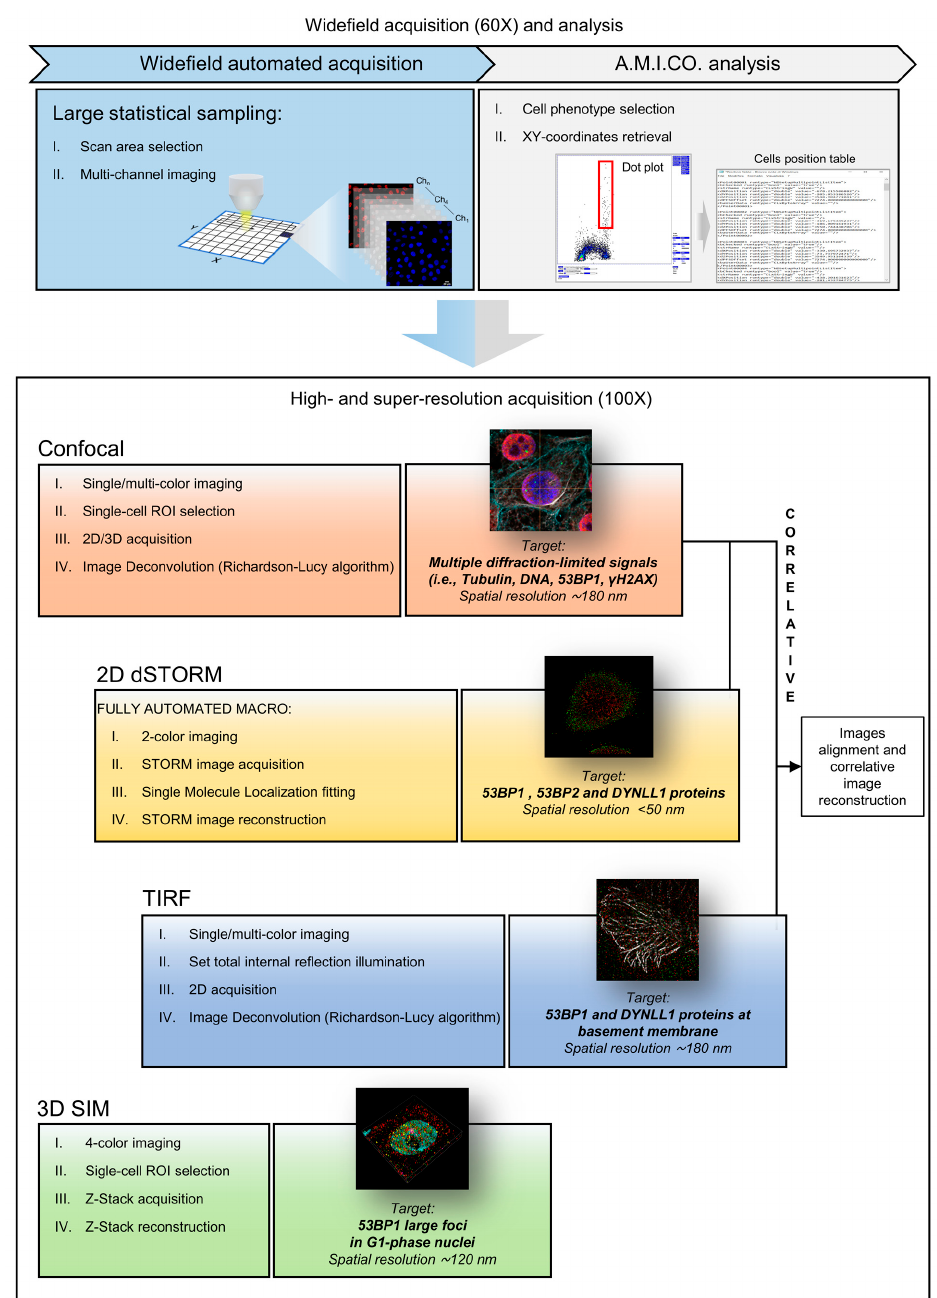
Figure 2. Multi ‐ Modal Multi ‐ Resolution Workflow for Correlative Experiments. First, images are Figure 2. Multi-Modal Multi-Resolution Workflow for Correlative Experiments. First, images collected by an automated fluorescence ‐ microscopy workstation following an analysis ‐ driven pro ‐ are collected by an automated fluorescence-microscopy workstation following an analysis-driven tocol (A.M.I.CO analysis) that allows the automated acquisition of multi ‐ channel images with high protocol (A.M.I.CO analysis) that allows the automated acquisition of multi-channel images with high resolution and their processing to identify single events. Cell targets of interest (specific cell phenotypes) are thus selected and physically retrieved on the microscope by converting the image coordinates into stage positions. High- and super-resolution imaging (including confocal, STORM, TIRF, and related correlative modalities) is then performed on the targeted